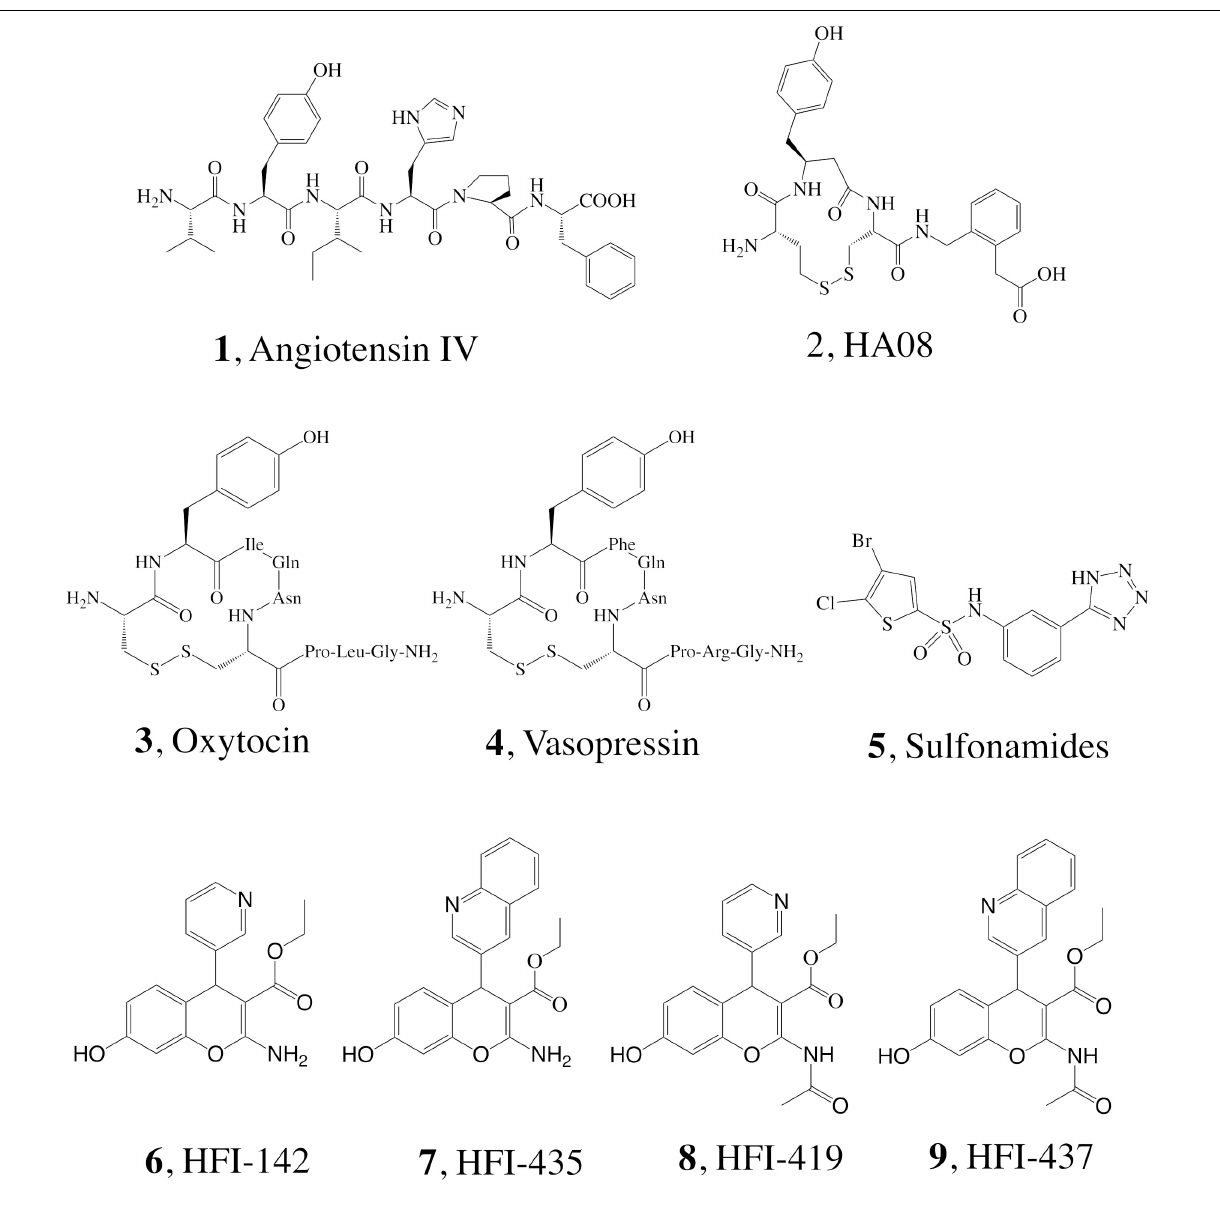
FIGURE 1 | Structure of IRAP inhibitors and